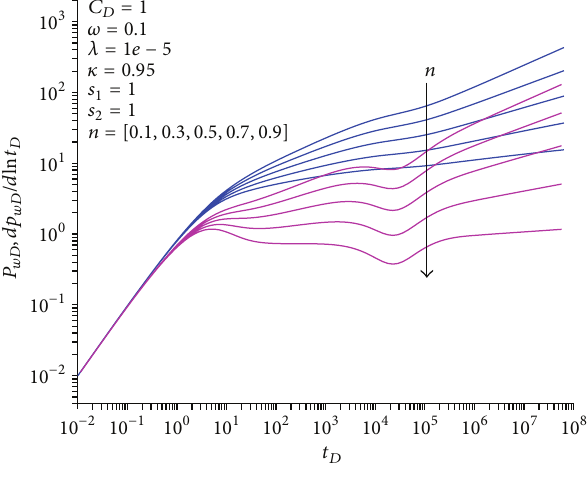
Figure 2: Dimensionless pressure for two-layer system.